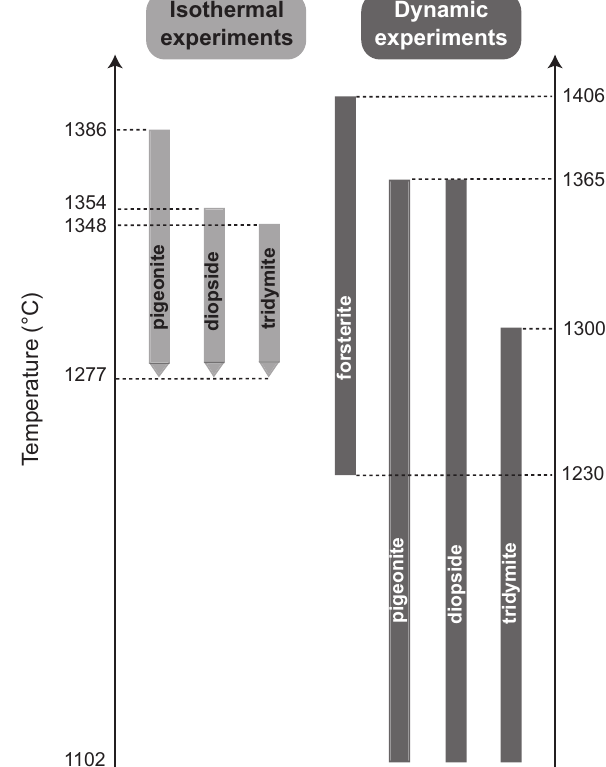
Figure 8. Photomicrographs showing pyroxene morphologies ob- Fig. 8. Photomicrographs showing pyroxene morphologies observed in dynamic crystallization experiments. a: Dendritic pigeonite growing on a rounded forsterite crystal (CPX09). b: Chain served in dynamic crystallization experiments: (a) dendritic pi- diopside nucleation and growth on a plate olivine crystal. c: Plumose zoned pyroxene between platy olivine crystals (CPX09). d: Dendrites on complex pyroxene crystal (CPX14). e+f: Zoned pyroxene geonite growing on a rounded forsterite crystal (CPX09), (b) chain needles, growing downwards and parallel to each other. diopside nucleation and growth on a plate olivine crystal, (c) plumose zoned pyroxene between platy olivine crystals (CPX09), (d) dendrites on complex pyroxene crystal (CPX14), and (e, f) zoned pyroxene needles, growing downwards and parallel to each other.